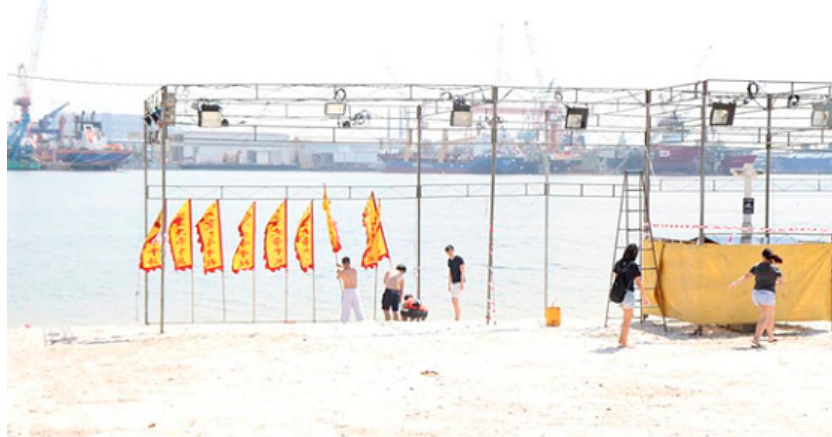
Figure 4. Temple volunteers place flags on the beach, while a surveillance camera (far right) overlooks them.